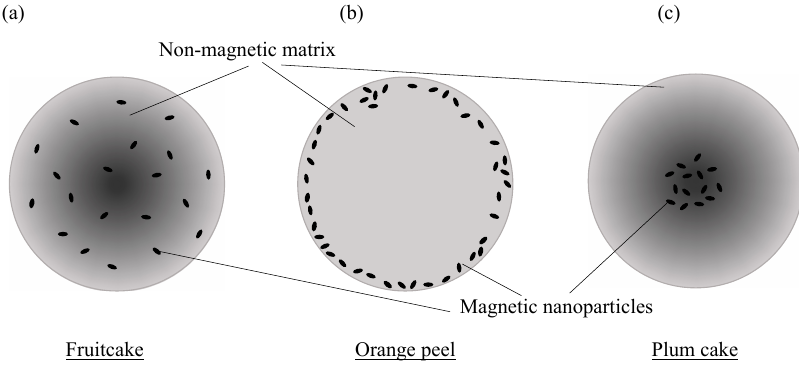
Figure 3. Variations of nanoparticle embedding in a non-magnetic spherical matrix creating superparamagnetic beads, from left to right: ( a ) fruitcake, ( b ) orange peel (cross-section), and ( c ) plum cake like distribution of magnetic nanoparticles.